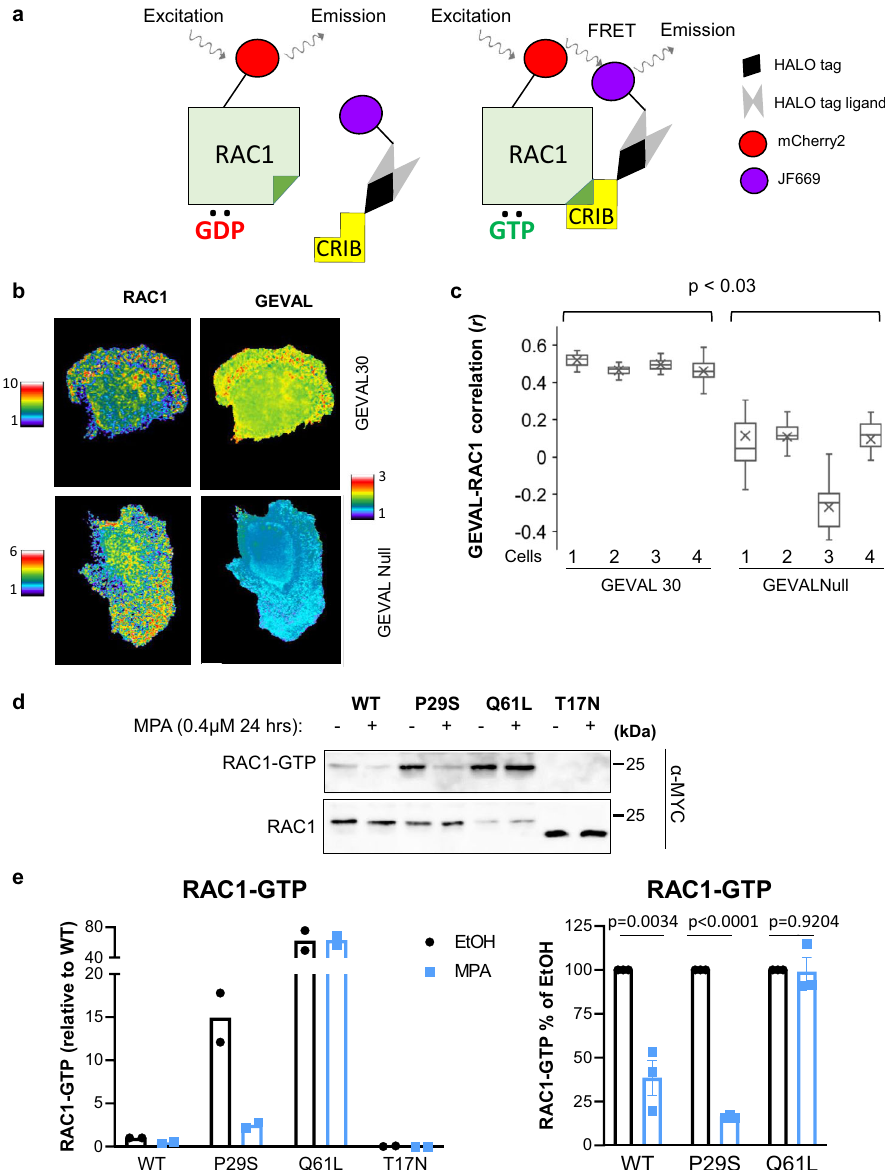
Fig. 3 Localization of regions with high RAC1 activity and high local GTP concertation. a Schematic representation of the RAC1 FRET (Förster